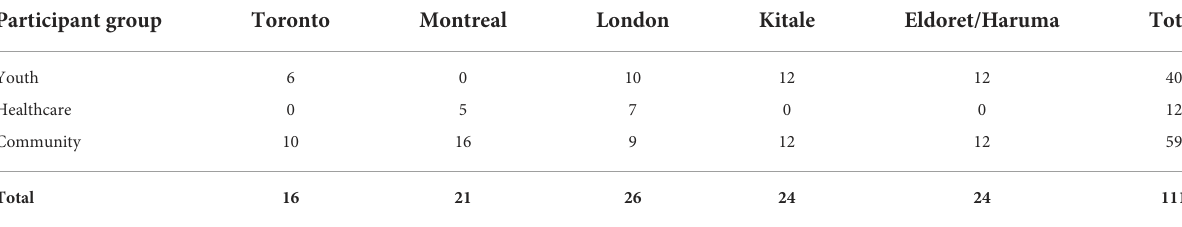
TABLE 2 Theatre Testing